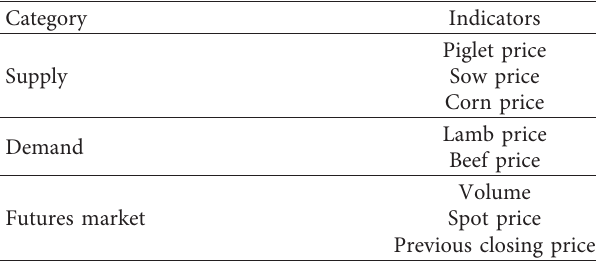
Table 3: Final indicators of hog futures price impact